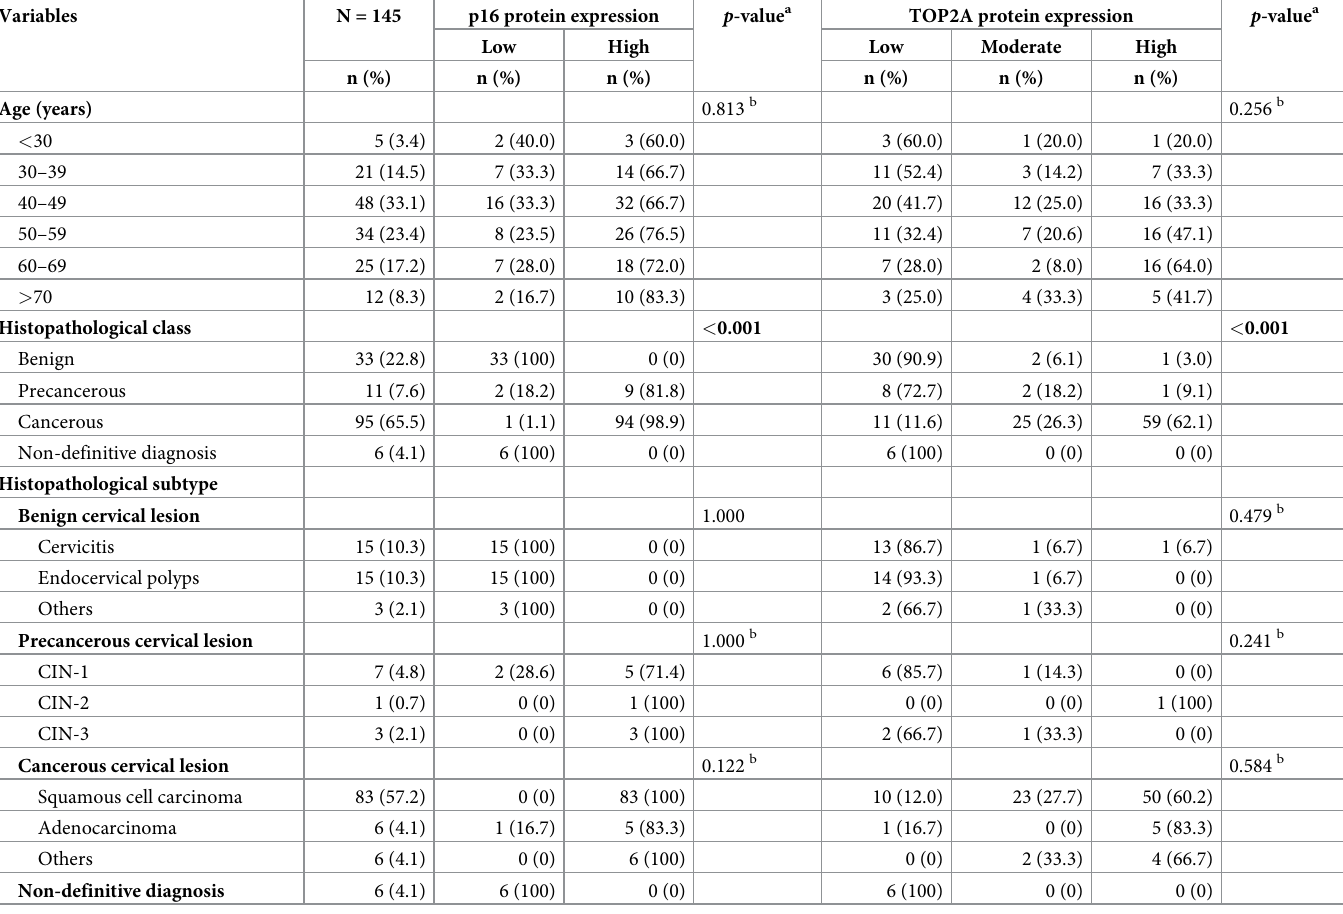
Table 2. Association between clinico-histopathological features and protein expressions among women seeking care at Kilimanjaro Christian Medical Centre (n =